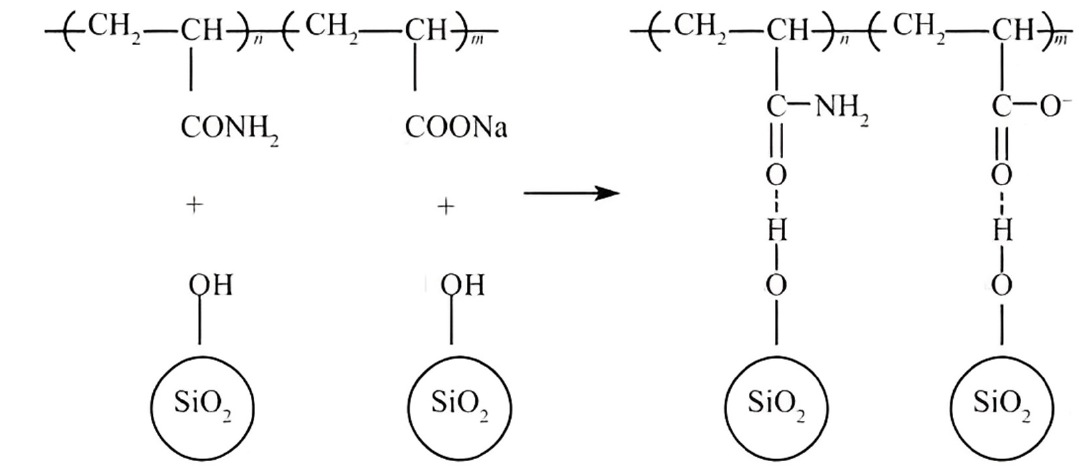
Figure 2. ( A ) Anti-high temperature plugging gel expansion rate [67]. ( B ) Curve diagram of the influence of flexible fiber content on the stable value of storage modulus. ( a ): Before adding flexible fibers. ( b ): After adding the flexible fiber [68]. ( C ) Thermogravimetric analysis curves of high-temperature-resistant fiber reinforced gel particles [68]. ( D ) Analysis of the temperature resistance before and after adding DE. ( a ): DE-0; ( b ): DE-9 [69]. ( E ) Analysis of the glassing temperature before and after adding DE. ( a ): DE-9; ( b ): DE-0 [69]. ( F ) Structure diagram of DE and HPAM forming hydrogen bond